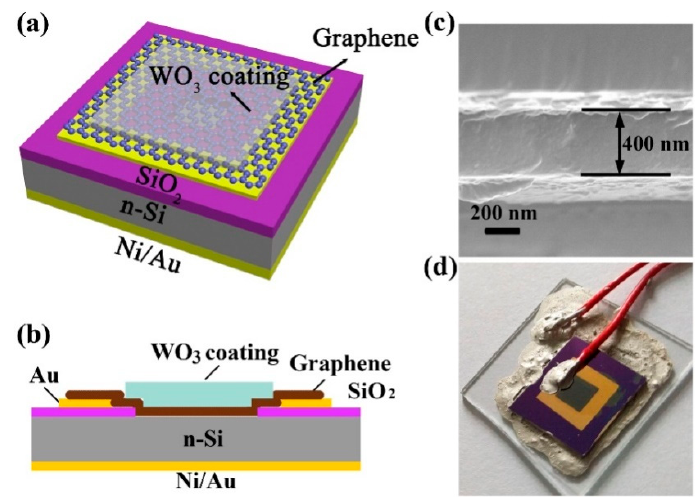
Figure 7. Device architecture of the tandem gasochromic-Pd-WO 3 / graphene / Si optoelectronic hydrogen sensor. ( a ) Tilted schematic device structure; ( b ) Cross-sectional schematic structure;( c ) Cross-sectional SEM image; ( d ) Optical photograph of a produced device [122]. Copyright (2020), with permission from Elsevier.